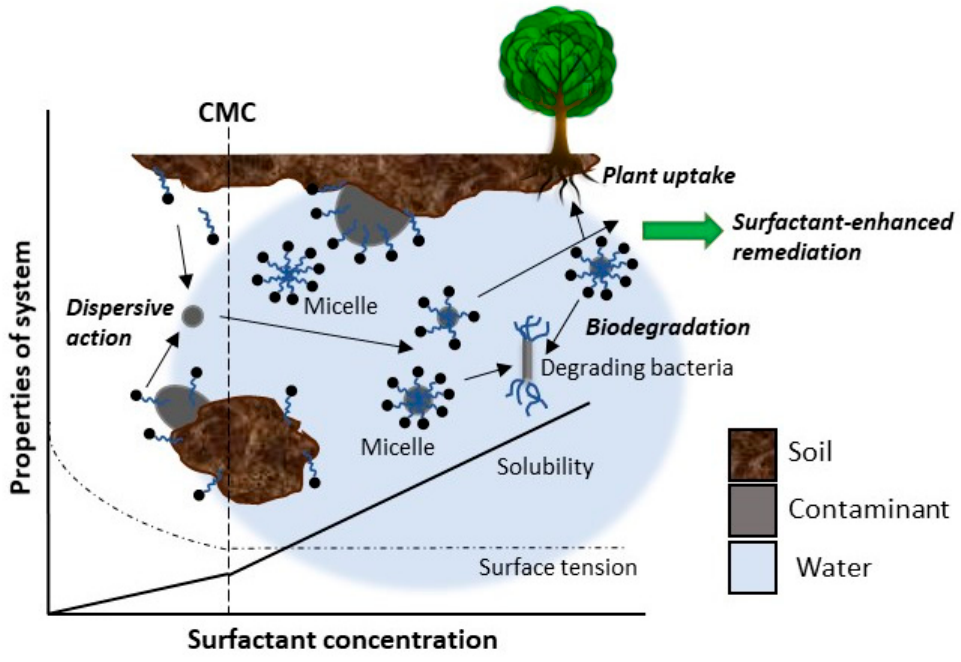
Figure 11 . Scheme of surfactant-enhanced remediation of polluted soil (adapted from [108]). Figure 11. Scheme of surfactant-enhanced remediation of polluted soil (adapted from